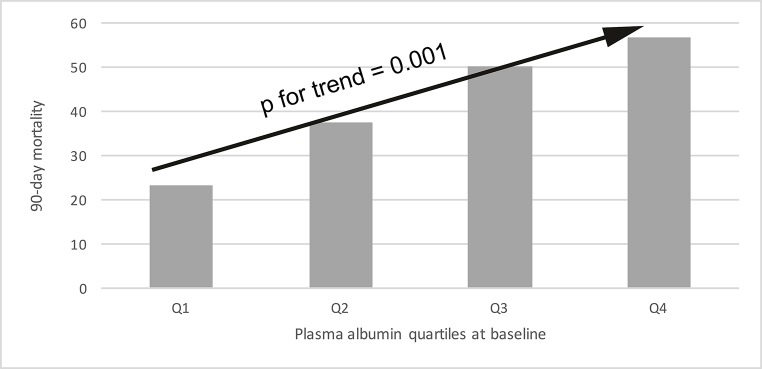
90-day mortality by baseline albumin quartiles.The P-Alb ranges for the quartiles were 34.0–42.9 g/L for the 1st quartile, 30.0–33.9 g/L for the 2nd quartile, 25.9–29.9 g/L for the 3rd quartile and 10.4–25.9 g/L for the 4th quartile.